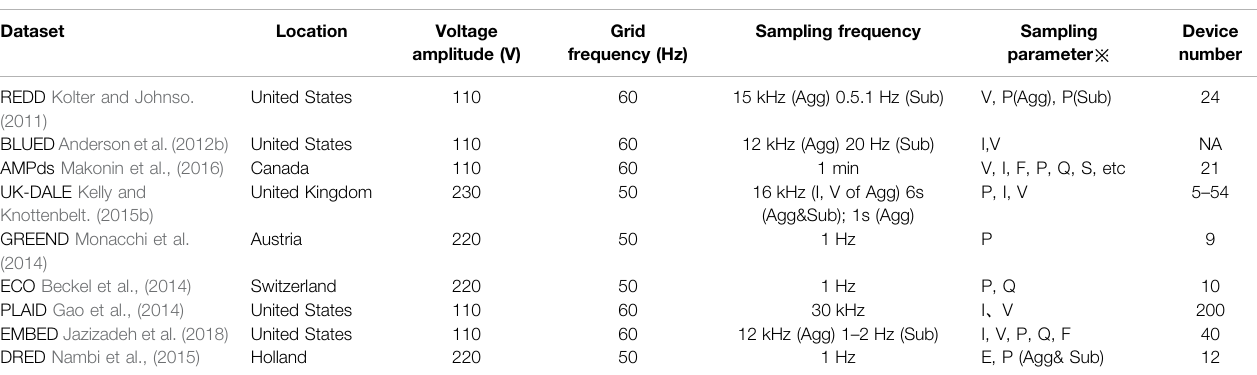
TABLE 1 | Main differences between popular load